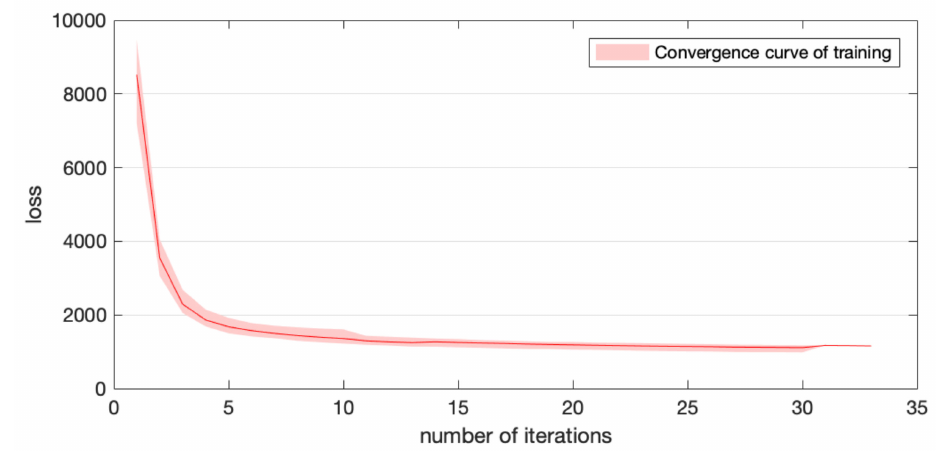
Figure 10. Average value and range of convergence curve in 10 training processes.